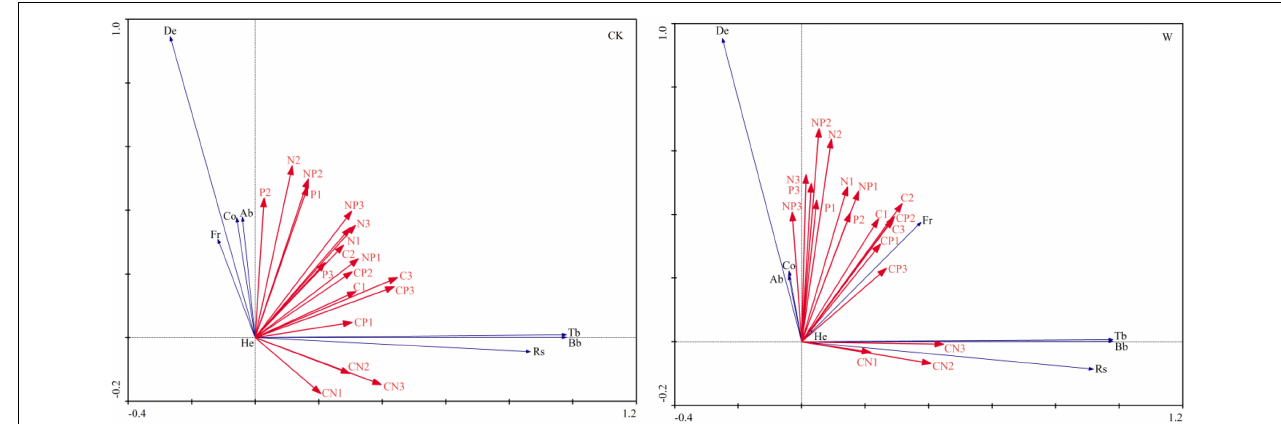
FIGURE 4 | Redundancy analyses of the relationships between plant growth indices and soil stoichiometric characteristics under control (CK) and warming (W) treatments in an alpine meadow. De, plant density; He, plant height; Fr, plant frequency; Co, plant coverage; Ab, plant aboveground biomass; Bb, plant belowground biomass; Tb, plant total biomass; Rs, plant root and shoot ratio. In the following, 1, 2, and 3 represent soil depths of 0–10, 10–20, and 20–30 cm, respectively. C1, C2, and C3 are soil carbon content; N1, N2, and N3 are soil nitrogen content; P1, P2, and P3 are soil phosphorus content; CN1, CN2, and CN3 are the soil carbon and nitrogen ratios; CP1, CP2, and CP3 are the soil carbon and phosphorus ratios; NP1, NP2, and NP3 are the soil nitrogen and phosphorus